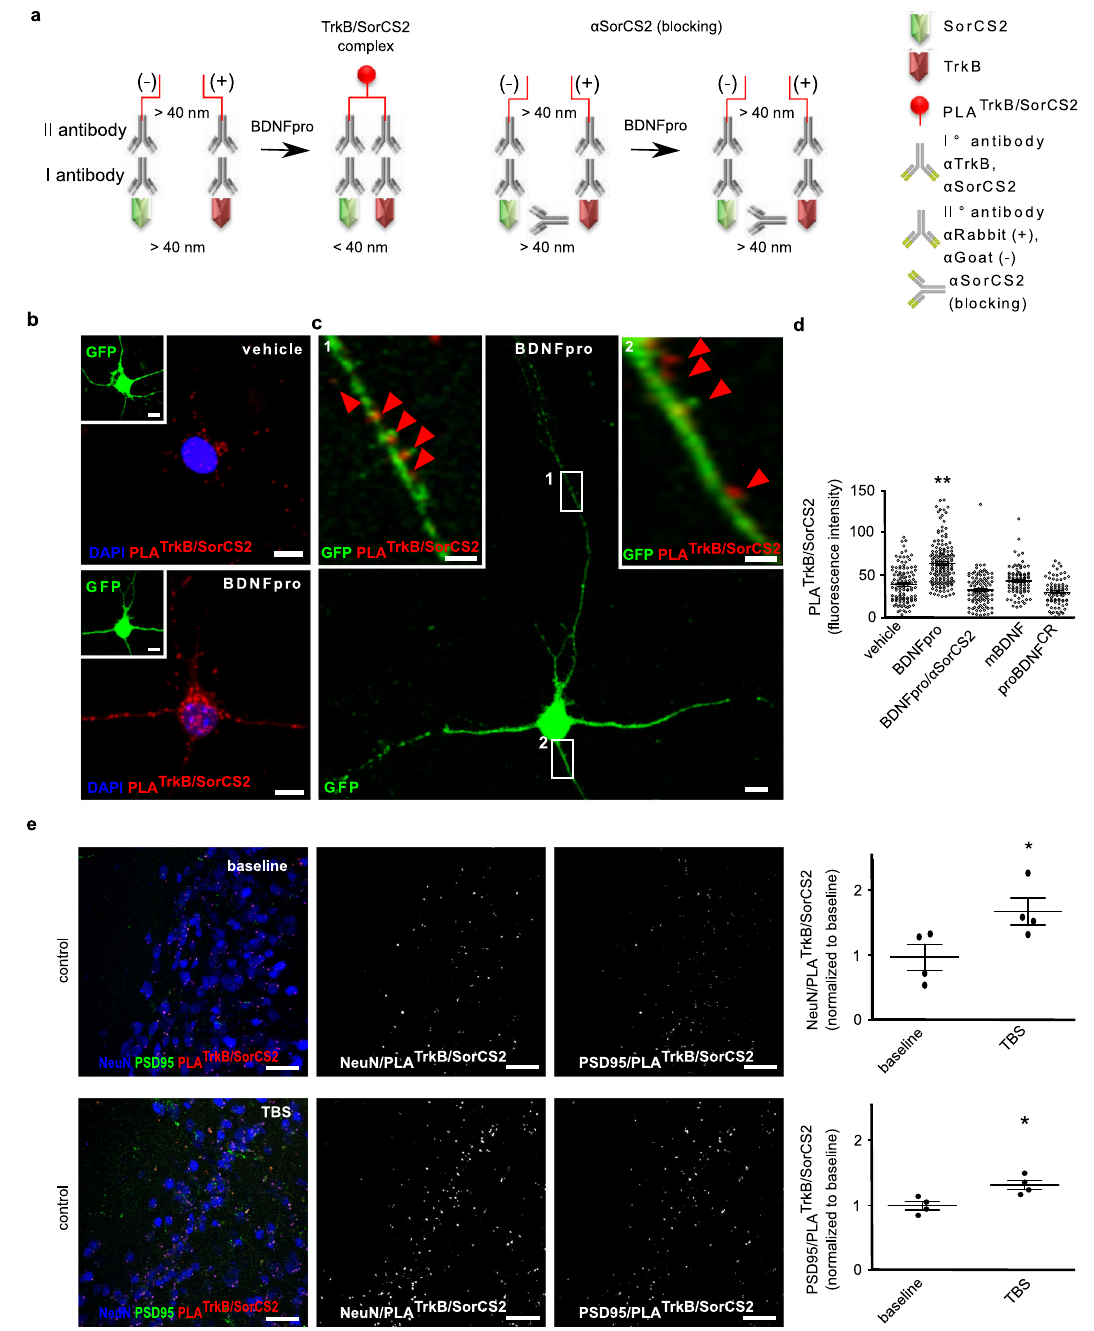
Fig. 6 post-synaptic targeting of TrkB/SorCS2 complex. a Schematic representation of the experimental design. Circular DNA probes ( − ) and ( + ) are coupled to II° antibody targeting α SorCS2 and α TrkB I° antibody. BDNFpro induces TrkB/SorCS2 complex formation (PLA TrkB/SorCS2 ) that is prevented in the presence of α SorCS2 (blocking) antibody. b Panels show PLA TrkB/SorCS2 signals in primary culture of cortical neurons treated with vehicle or BDNFpro. The insets show reference GFP-neurons. Scale bars: 5 μ m. c Panels show a GFP-neuron treated with BDNFpro. Scale bar: 5 μ m. Magni fi cation of regions of interest 1 and 2 shows dendritic PLA TrkB/SorCS2 localization (red arrowheads). Scale bar: 1 μ m. d Quanti fi cation of PLA TrkB/SorCS2 signal in cultured neurons treated with vehicle, BDNFpro (in presence or absence of α SorCS2), mBDNF or proBDNF CR . Data are presented as mean ± SEM; ** p < 0.01 (unpaired t - test) ( n = 111 cells, 3 cultures for vehicle; n = 152 cells, 4 cultures for BDNFpro; n = 98 cells, 3 cultures for BDNFpro/aSorCS2; n = 89 cells, 3 cultures for mBDNF; n = 79 cells, 3 cultures for proBDNF CR ). e z-stack reconstruction showing NeuN, PSD95 and PLA TrkB/SorCS2 signals in baseline and TBS slices. NeuN/PLA TrkB/SorCS2 and PSD95/PLA TrkB/SorCS2 colocalization signals are shown. Scale bars: 40 μ m. NeuN/PLA TrkB/SorCS2 and PSD95/PLA TrkB/SorCS2 colocalization was quanti fi ed using Mander ’ s overlap. Data are normalized to baseline and presented as mean ± SEM; * p < 0.05 (unpaired t -test) ( n = 4 slices, 3 mice for each experimental